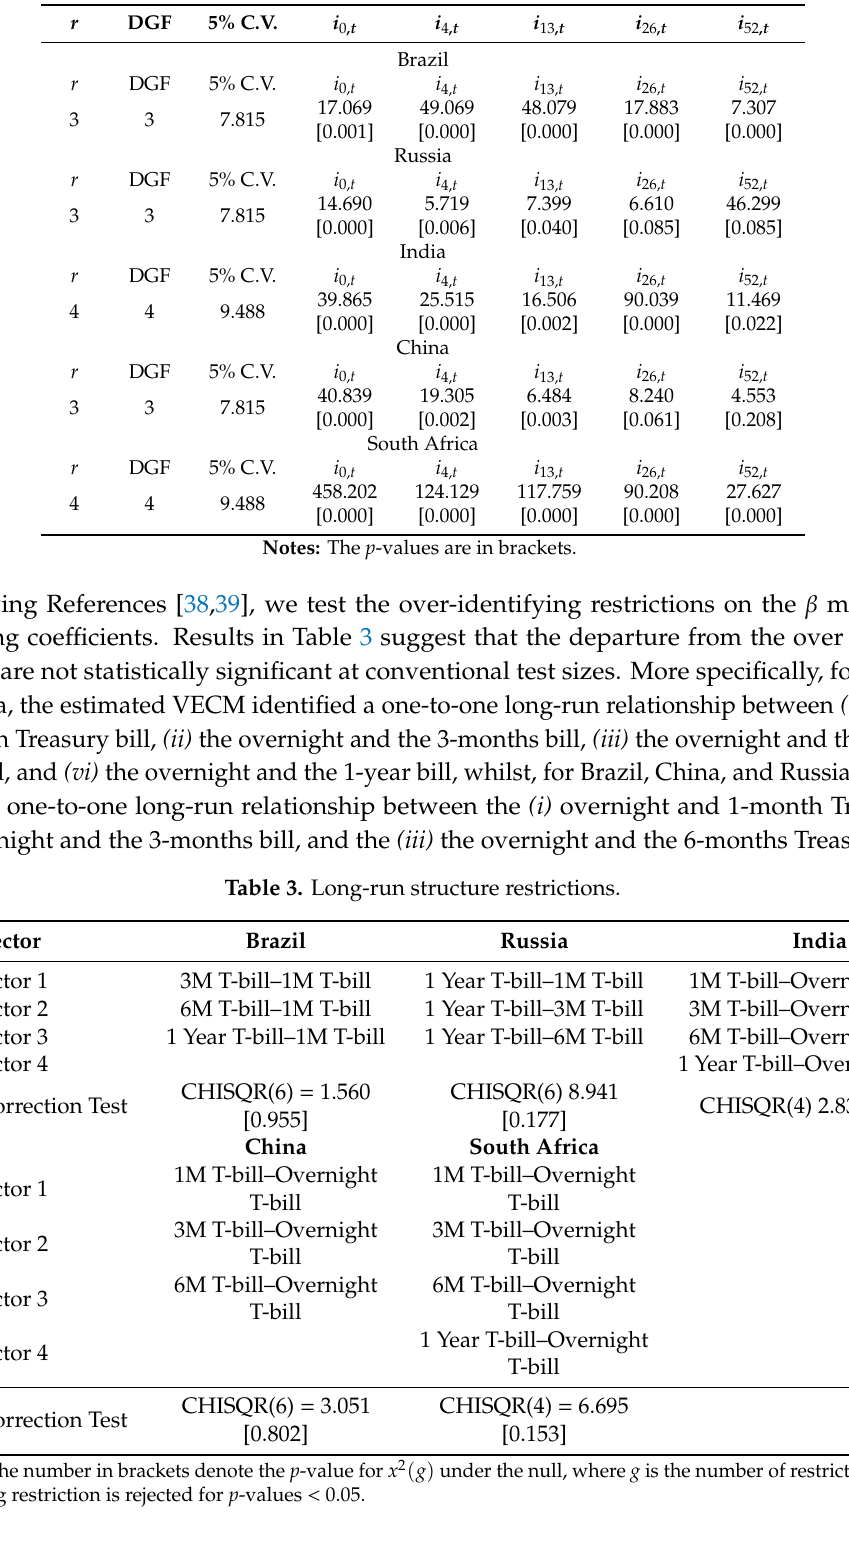
Table 2. Weak exogeneity testing.